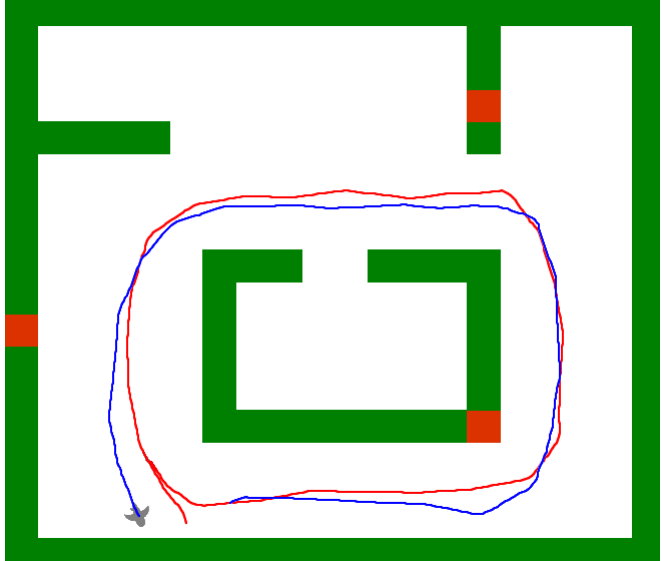
Figure 13. Backward navigation: the agent follows the path backwards to return to its starting position (blue trajectory), using only visual odometry and relative distance between place cells. The path is however not very precise due to the motion drift that is not